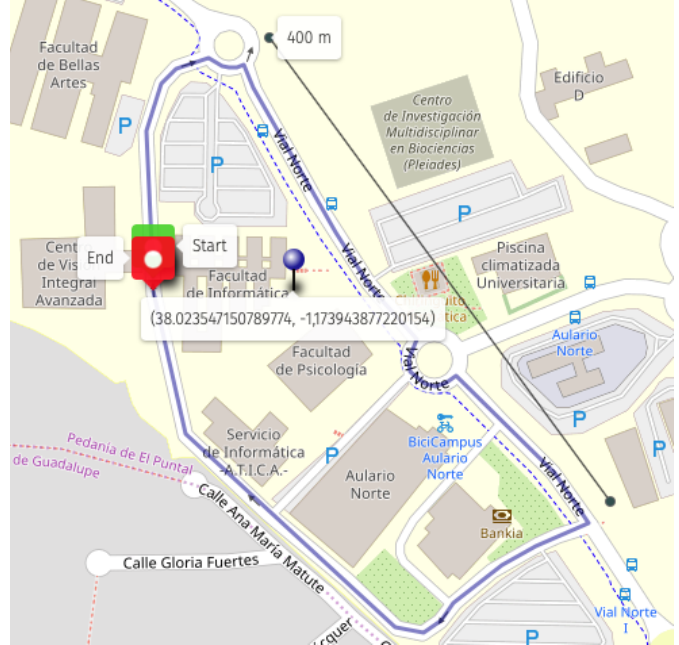
Figure 4. Test-site and path followed by the